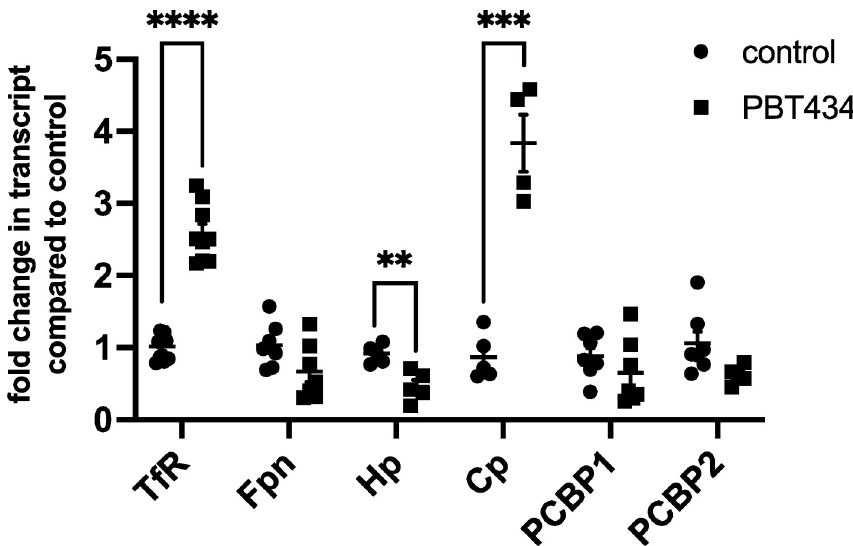
Fig 6. qPCR analysis of transcript abundance in PBT434-treated hBMVEC. hBMVEC were treated with 20 μ M PBT434 or PBT434-met for 24h. RNA was collected and reverse-transcribed, and the resulting cDNA was quantified by qPCR. Transcript abundance in each sample was normalized to β -actin transcript, and the results are represented as the mean ± SEM fold change relative to control cells, n = 4–8 samples/condition. Statistical significance was determined by unpaired t-test between control and treated cells for each transcript; ���� , p < 0.001 compared to control.